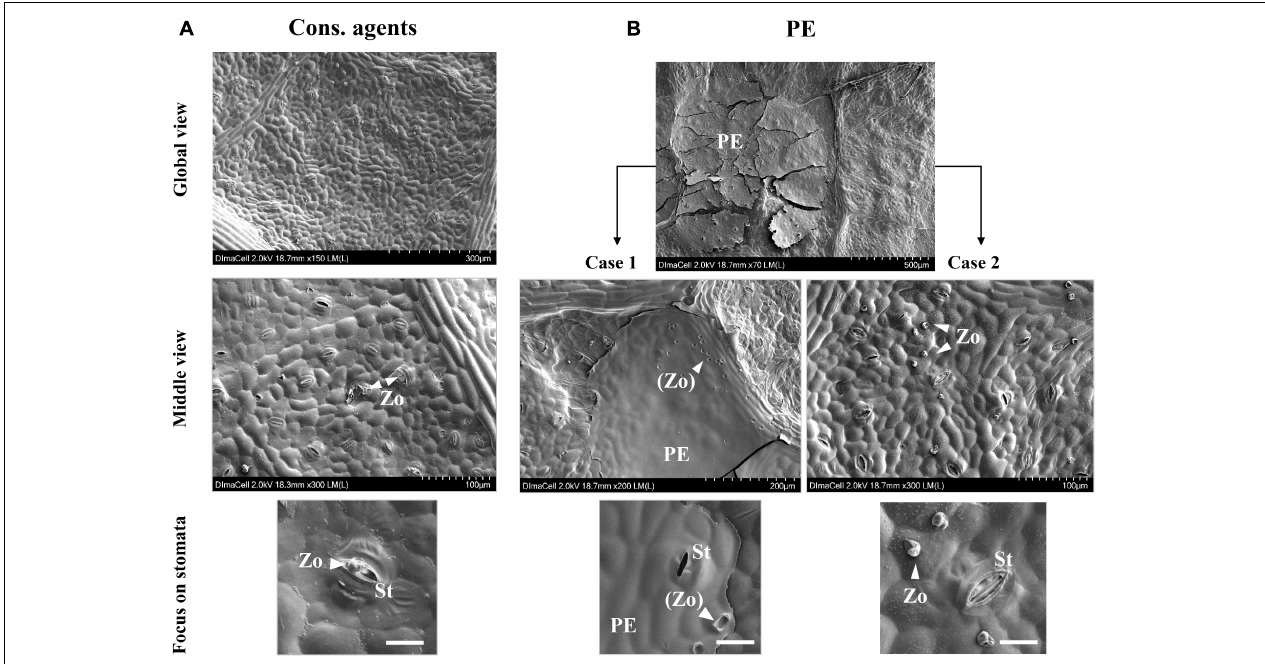
FIGURE 9 | SEM observation of leaf surfaces at 24 hpi after treatment by cons. agents (A) or PE (B) treatments, and P. viticola inoculation (10 5 sporangia mL − 1 ). Top line of pictures show global overview of leaf surface to evidence deposits left on leaf surfaces or not; center line of pictures show middle view in order to point out zoospore presence around potential infection sites. For PE treatments, two cases were observed: (1) dried PE droplet forming a thin layer covering stomata access, or (2), outside of any dried droplet deposit, zoospores not encysted in stomata. Bottom line of pictures show focuses on stomata in each case. PE, PE droplet residue; St, stomata; Zo, zoospore; (Zo), zoospore ‘footprints.’ Embedded scale bars display the corresponding size on pictures: Global view = 300 or 500 µ m; Middle view = 100 or 200 µ m; Focus on stomata = 20 µ